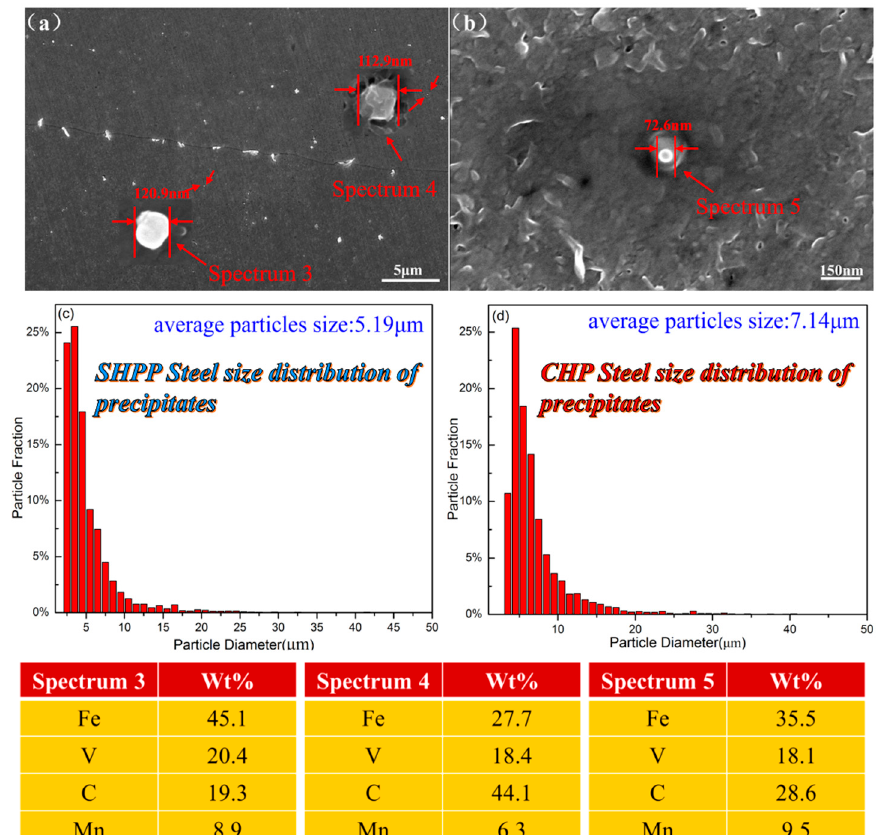
Figure 12. ( a ) FESEM micrographs of the distribution of submicron-scale precipitates in SHPP steel. ( b ) FESEM micrographs of the nano-scale precipitates in SHPP steels. Precipitate particle size distribution of SHPP steel ( c ) and CHP steel ( d ). Energy spectrum analysis (bottom of the picture) of precipitates (marked by red arrows) in ( a ) and ( b ) FESEM micrographs.